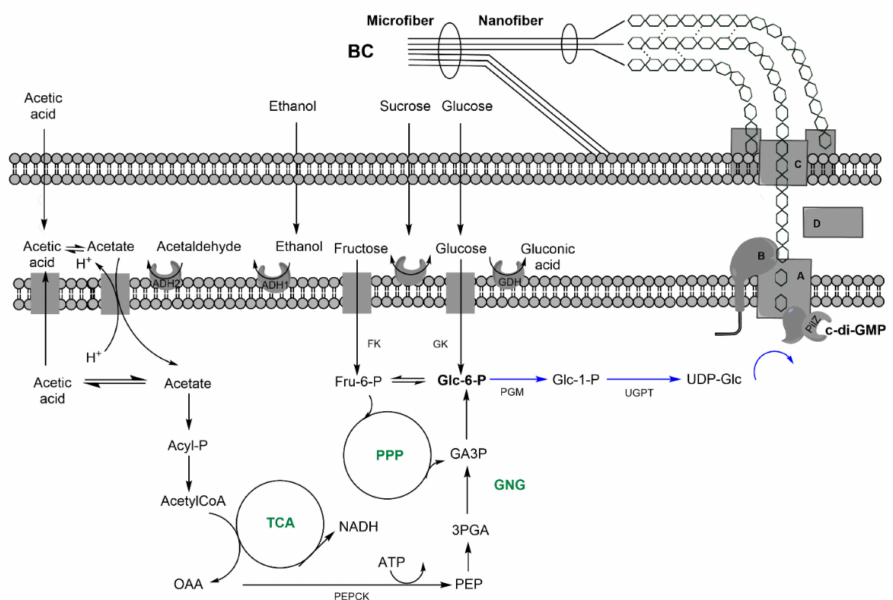
Figure 2. Metabolic network of BC in Komagataeibacter xilynus E25. Sugars are metabolized through the pentoses phosphate pathway (PPP) to Glc-6-P, while glycolysis is not a relevant pathway in Komagataeibacter species due to the lack of phosphofructokinase. Glucose is partially oxidized in the periplasm to obtain reductor power. In the case of K. xylinus E25, the oxidation product is gluconic acid, although the final product is species-dependent. Ethanol is dehydrogenized to acetate by ADH1, an ADH2 inner-membrane-bound enzyme, and directed to Glc-6-P by the tricarboxylic acid cycle (TCA) and gluconeogenesis (GNG) pathways. Glc-6-P is isomerized to Glc-1-P by phosphogluco- mutase (PGM) and is subsequently transformed to UDP-Glc by UTP–Glc-1-P uridylyltransferase (UGPT). Upon activation by c-di-GMP of BcsA, UDP-Glc units are polymerized into nascent glucan chains coupled with its translocation to the periplasm by means of cellulose synthase subunits BcsA (A) and BcsB (B). BcsC (C) is then involved in the arrangement of the nascent chains, and BcsD (D) forms the pore to export the nanofibrils. The main metabolic pathways, TCA, GNG, and PPP, are indicated in green. The pathway leading to BC synthesis is indicated in blue. Key enzymes, phosphoglucoisomerase (PGI), phosphoenol pyruvate carboxykinase (PEPCK), PGM, and UGPT are indicated. OAA: oxalacetate; PEP: phosphoenol pyruvate; 3PGA: 3-phosphoglycerate; GA3P: